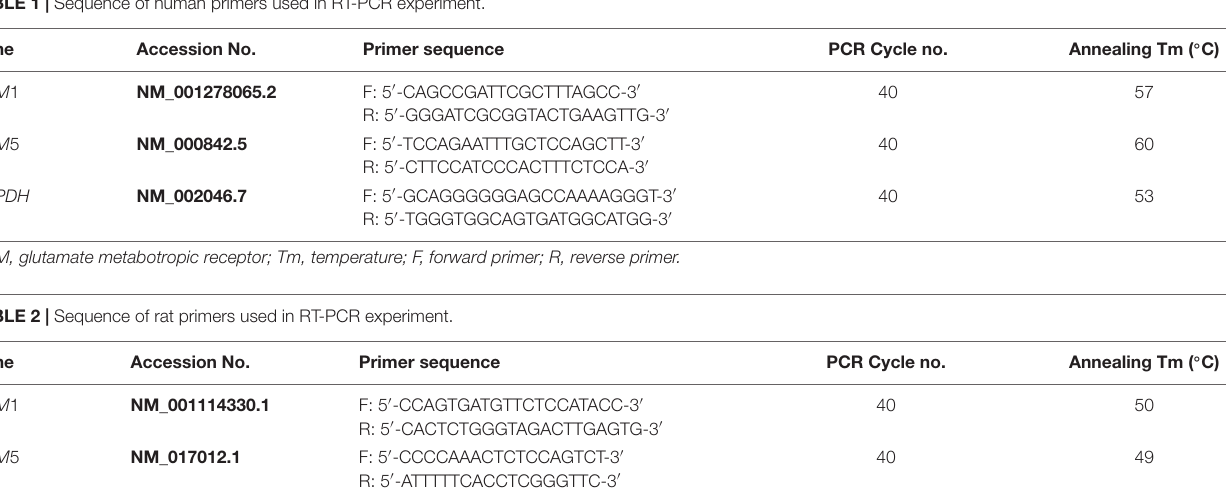
TABLE 1 | Sequence of human primers used in RT-PCR experiment.